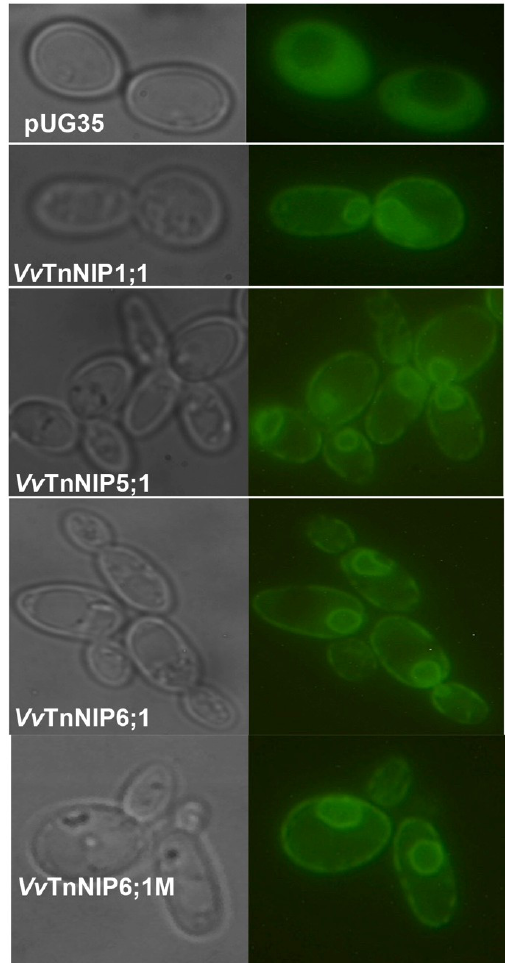
Figure 2. Membrane localization of GFP-tagged grapevine NIPs in aqy-null S. cerevisiae . Yeast cells transformed either with pUG35-GFP (control) or pUG35- Vv TnNIPs-GFP were observed under phase contrast (left panel) and fluorescence microscopy (right panel) at 100 × magnification.